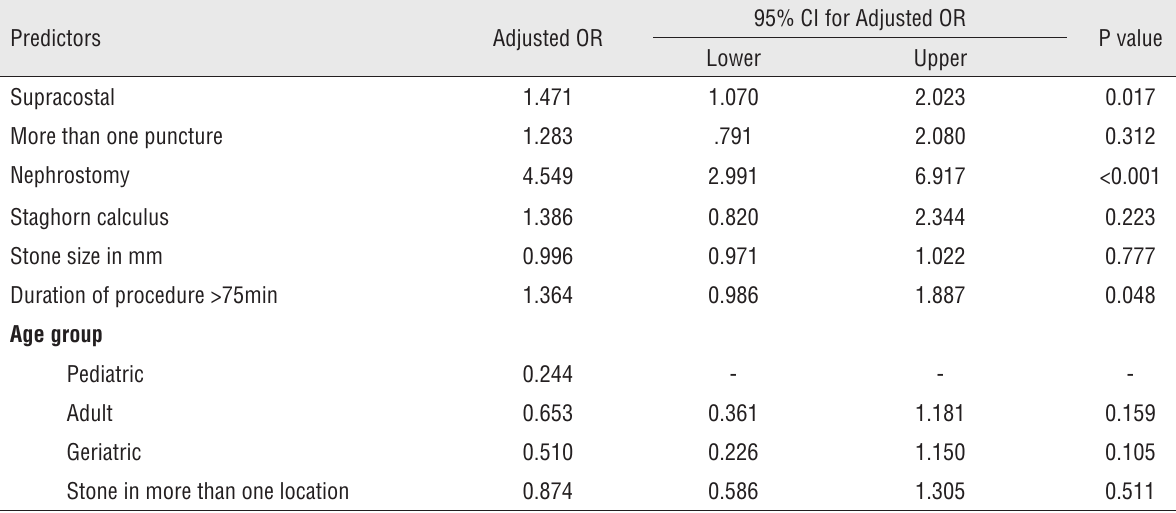
Table 3 - Logistic regression for predictors of complications.